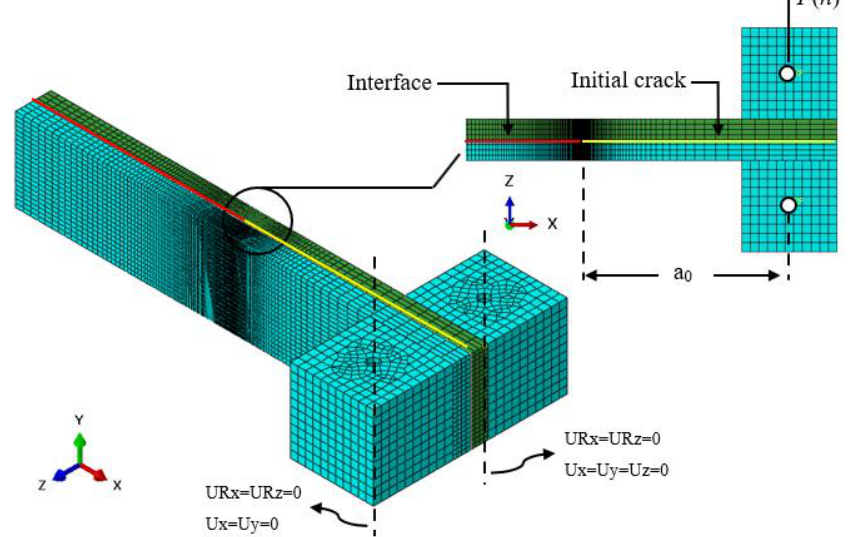
Figure 7. FE model of a DCB specimen demonstrating element mesh and boundary conditions.